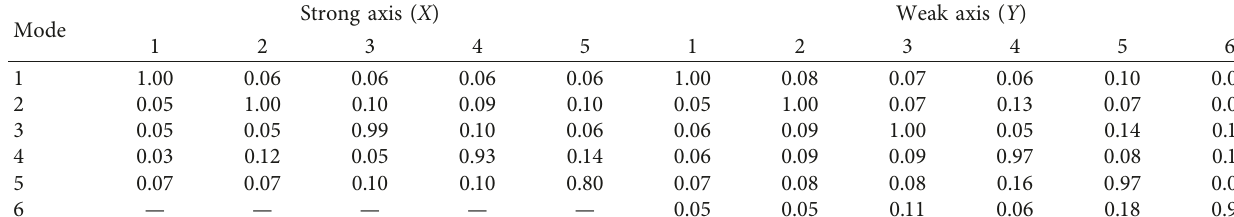
Table 5: MAC between the experimental and the analytical mode